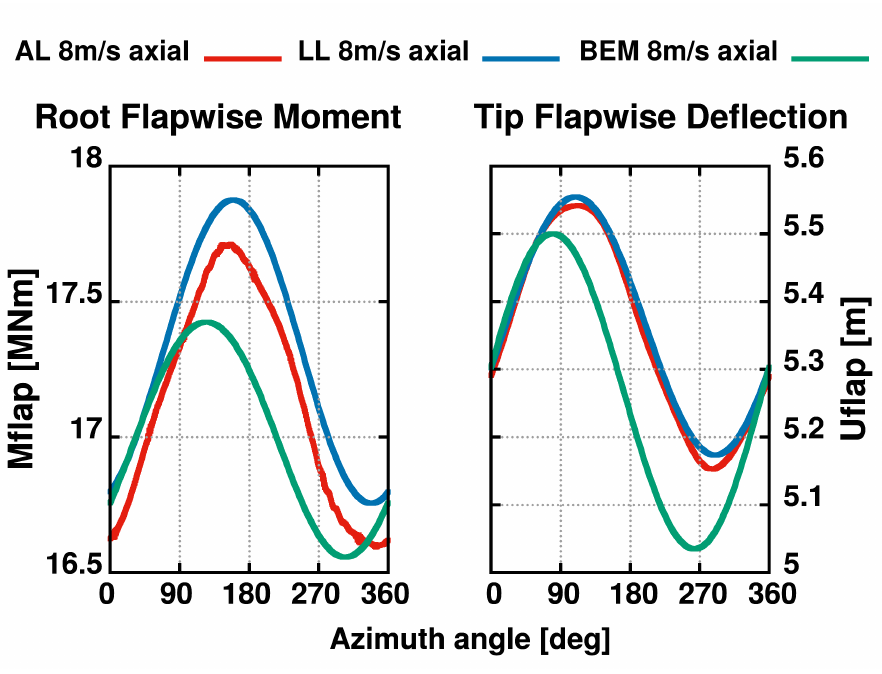
Figure 16. Out-of-plane root bending moment and tip deflection at 8 m/s axial wind speed.